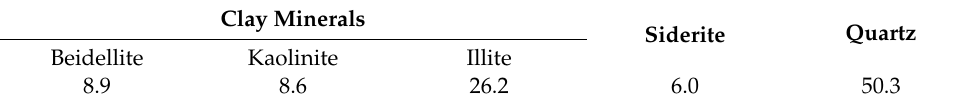
Table 3. Mineral composition of silty clay used